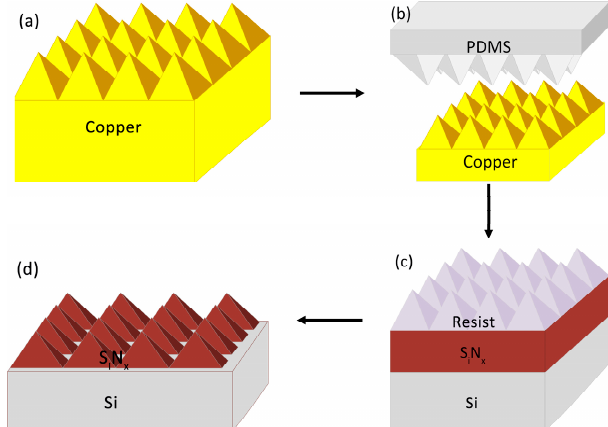
Figure 3. Preparation of micro-pyramid structured thin film for broadband infrared antireflection.